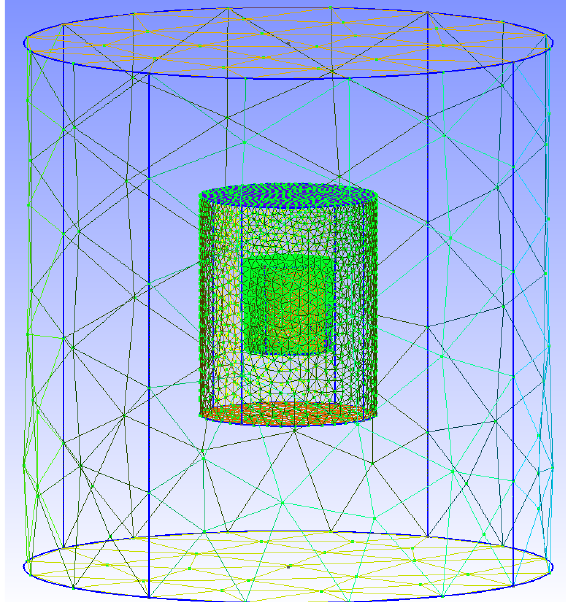
Fig. 1. The GMSH model of the simplified Solar Probe Plus space- craft used in SPIS simulations with the associated meshing grid. The z-axis described in the text is the vertical axis in this figure. From the outside to the inside the boundary of the simulation box, the intermediate meshing cylinder (which has no physical meaning) and the satellite cylinder can be distinguished.